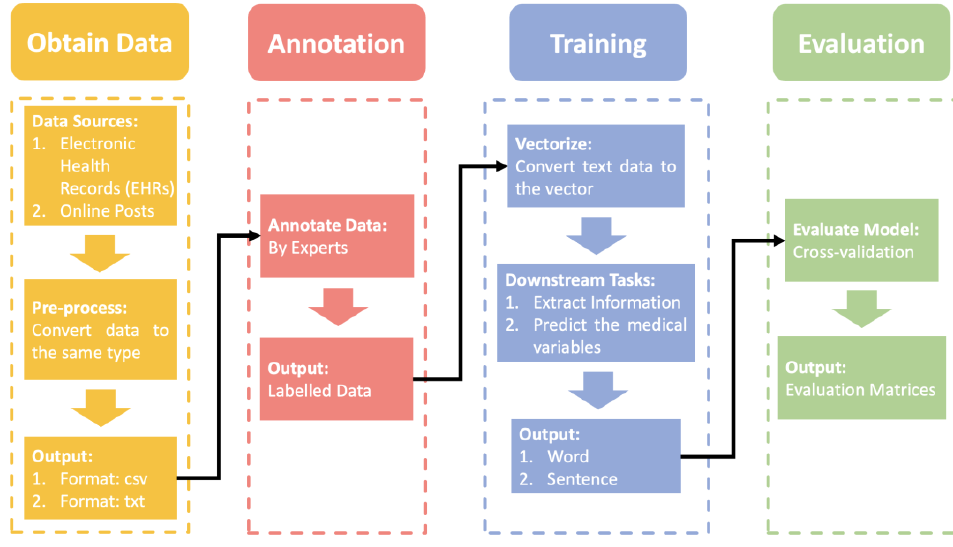
Figure 1. The overview of NLP pipelines in applications of breast cancer is explained.